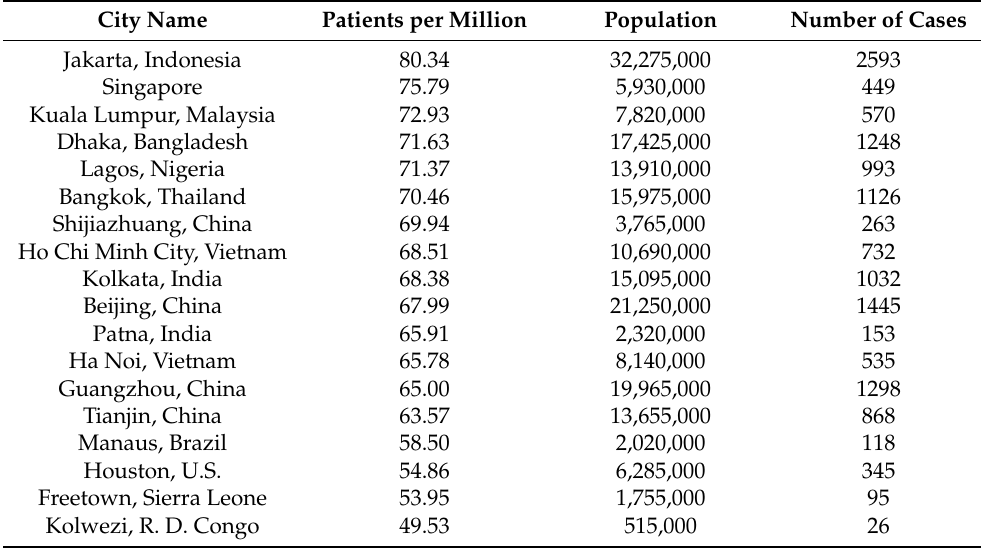
Table 5. Potential number of cancer cases in typical cities if HCHO surface concentration remains at 2019